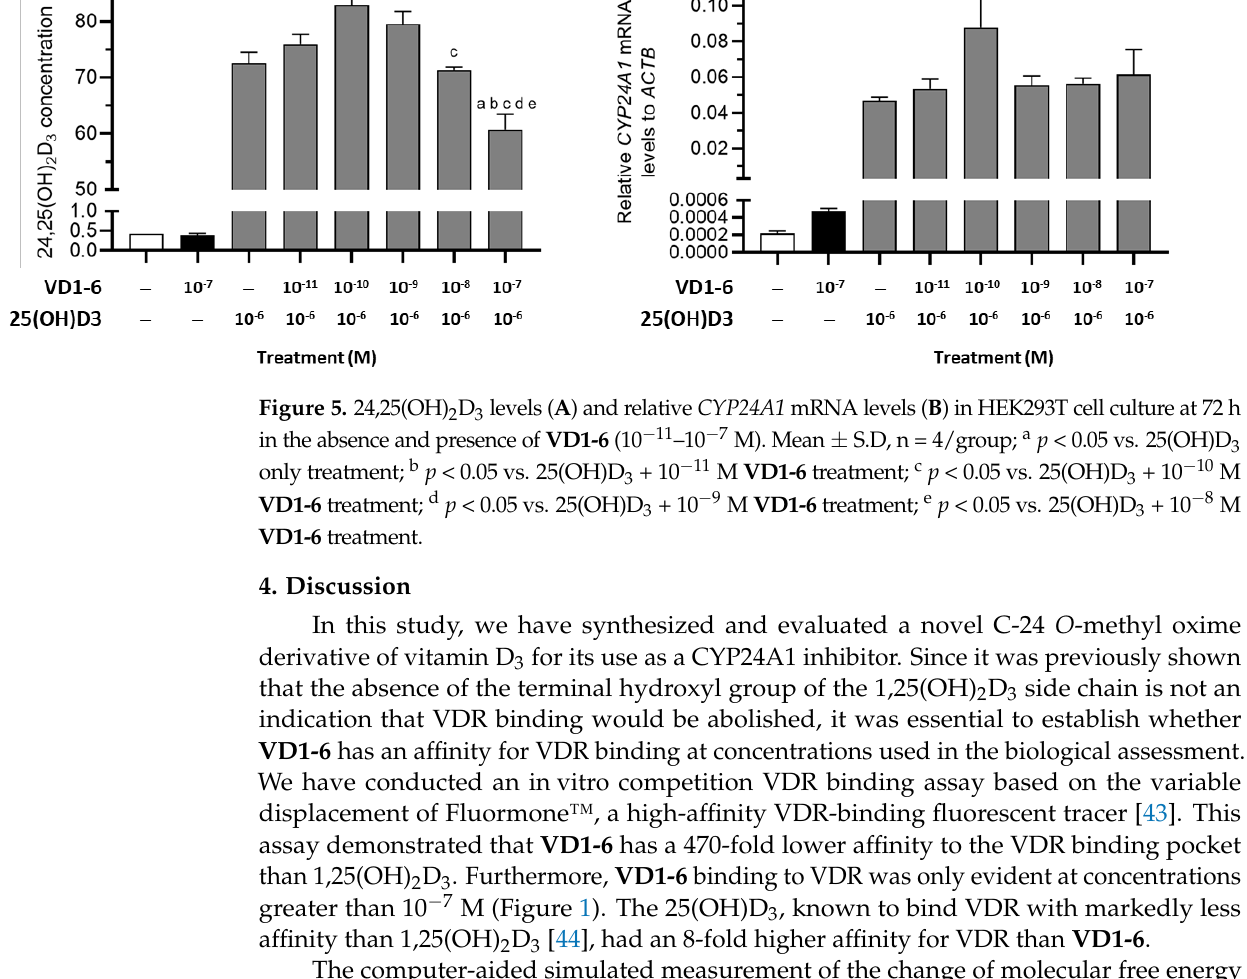
c c a Figure 4. Levels of 1,25(OH) 2 D 3 in HEK293T cell culture at 0, 8, and 24 h in the absence and presence of VD1-6 at 10 −8 M and 10 −7 M. Mean ± S.D, n = 4/group; a p < 0.05 vs 0 h; b p < 0.05 vs. 1,25(OH) 2 D 3 alone at 8 h; c p < 0.05 vs. 1,25(OH) 2 D 3 alone at 24 h. 3.6. Effect of VD1-6 on 24,25(OH) 2 D 3 Production in HEK293T Cell Culture To assess the effects of VD1-6 on 25(OH)D 3 catabolism, HEK293T cells were treated with 25(OH)D 3 (10 −6 M) over 72 h, and media levels of 24,25(OH) 2 D 3 and mRNA levels for CYP24A1 were measured in the absence or presence of VD1-6 (10 −1 1 – 10 −7 M) (Figure 5A,B ) . In the presence of 25(OH)D 3 (10 −6 M), HEK293T cells produced 24,25(OH) 2 D 3 , which was approximately 170-fold higher than the levels in the vehicle-treated cells (Figure 5A). The inclusion of VD1-6 resulted in a biphasic concentration-dependent effect on the mean ac- cumulated 24,25(OH) 2 D 3 concentrations. At 10 −1 0 M VD1-6 , a 14% increase in mean 24,25(OH) 2 D 3 concentration was observed when compared to levels with 25(OH)D 3 treat- ment alone ( p < 0.05) (Figure 5A). However, at 10 −7 M VD1-6 , a marked decrease in 24,25(OH) 2 D 3 levels was seen when compared to all other treatment concentrations ( Fig- ure 5A). Although 25(OH)D 3 treatment increased CYP24A1 mRNA levels in HEK293T